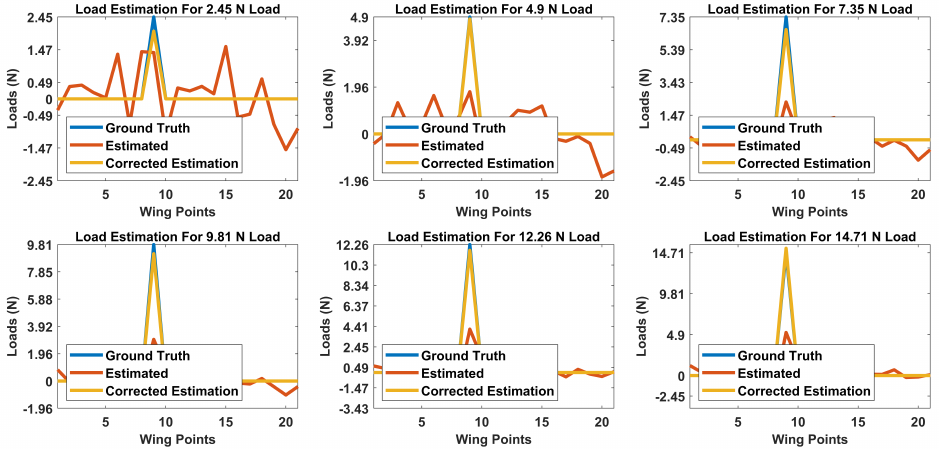
Figure A5. Optimized and corrected load estimations for distributed loads acting at point 9 of the